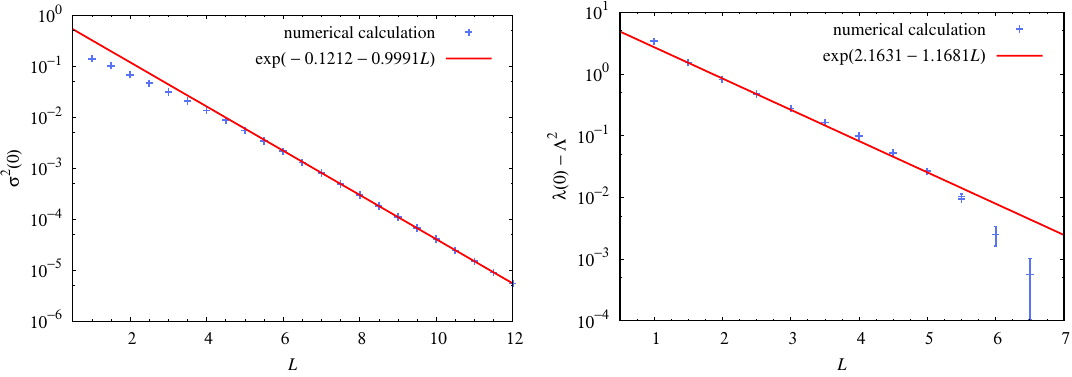
Figure 1 . The functions (cid:21) ( x ) (left) and (cid:27) 2 ( x ) (right) which are solutions to the gap equation, eq. (2.6), for various values of L ranging L = 1 (cid:24) 12. (cid:3) = 1 in this (cid:12)gure. The innermost (outermost) curve corresponds to L = 1 ( L = 12).